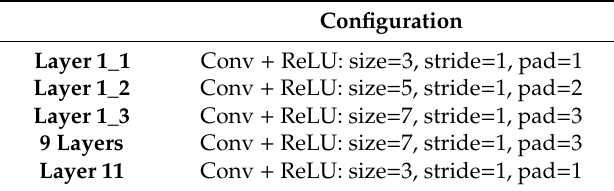
Table 2. The network configuration of the WSSRN